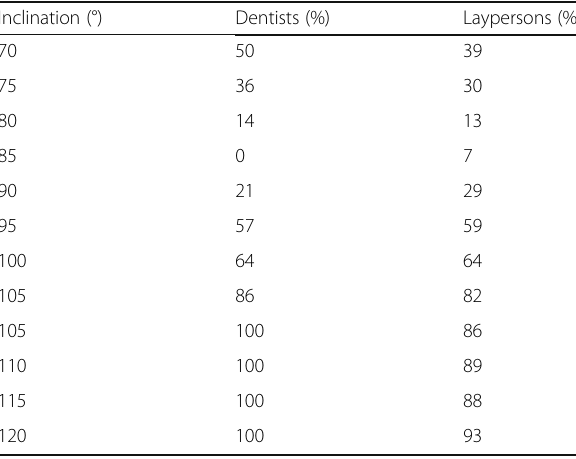
Table 3 Proportion of clinicians and laypeople suggesting a desire for treatment for images